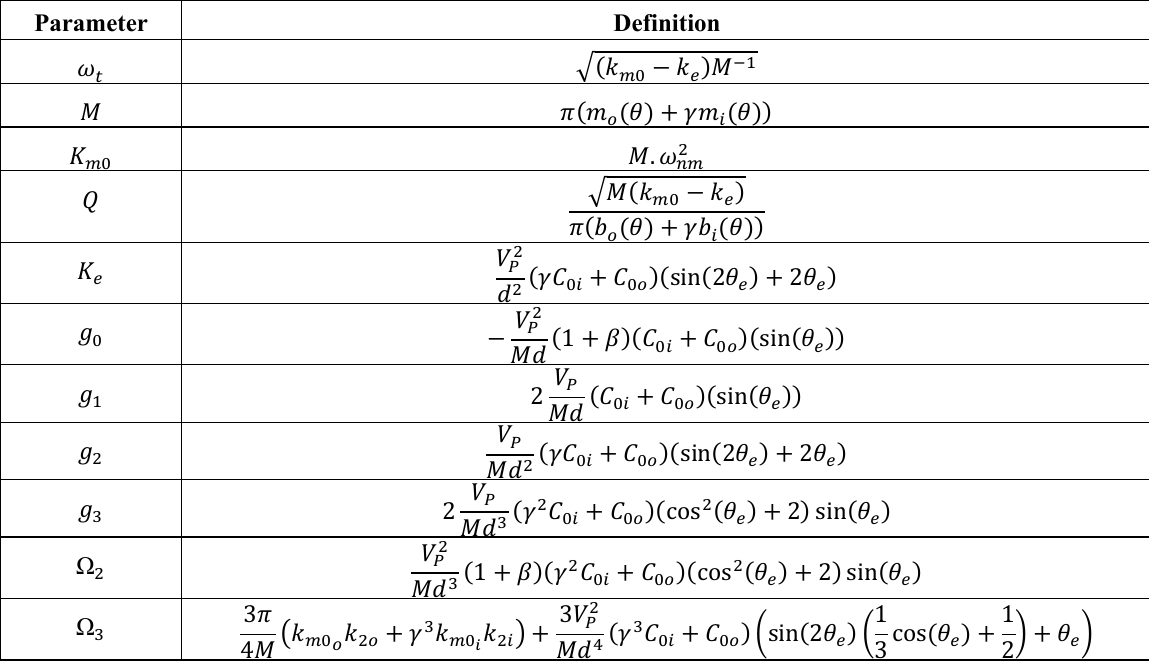
Table 2. Definitions used in Equation